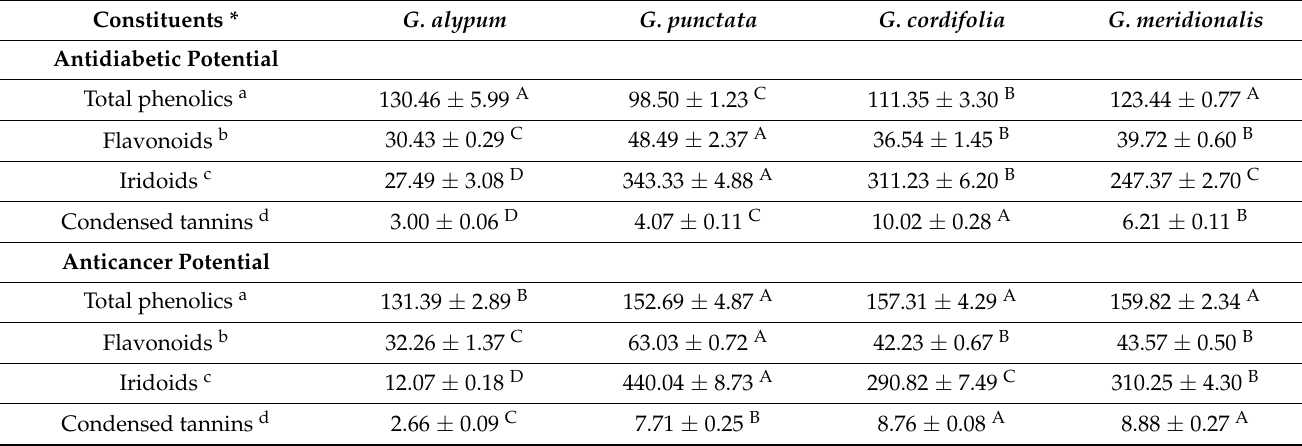
Table 1. Phytochemical content of methanolic leaf extracts of G. alypum , G. punctata , G. cordifolia